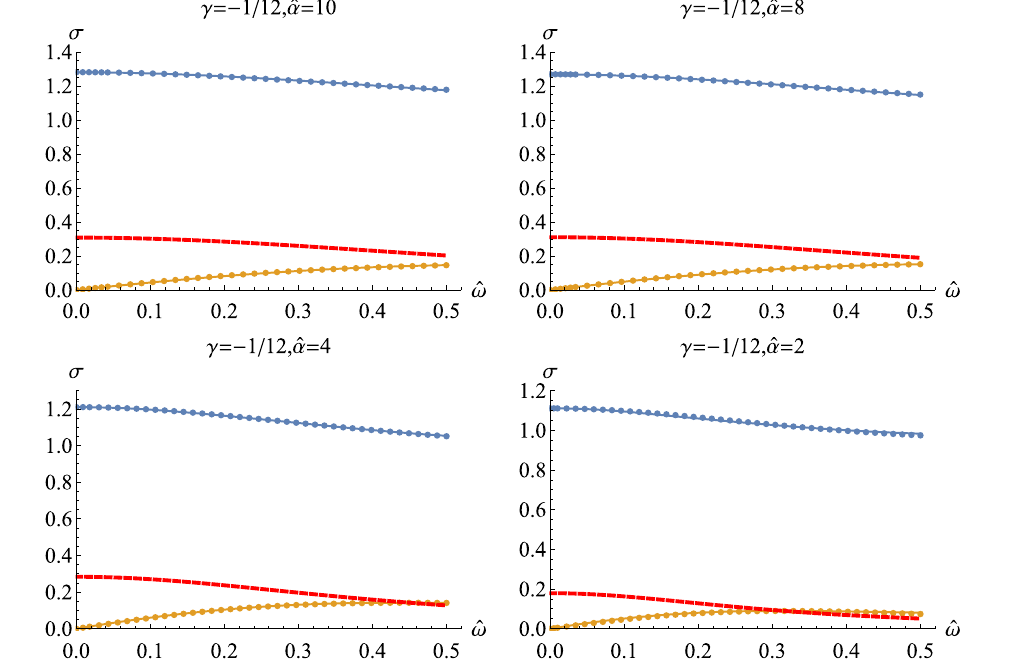
Fig. 4 The low frequency behavior of the optical conductivity with momentum dissipation for different ˆ α and γ = − 1 / 12. They are fitted by a modified Drude formula (22). The red dashed line is the real part of